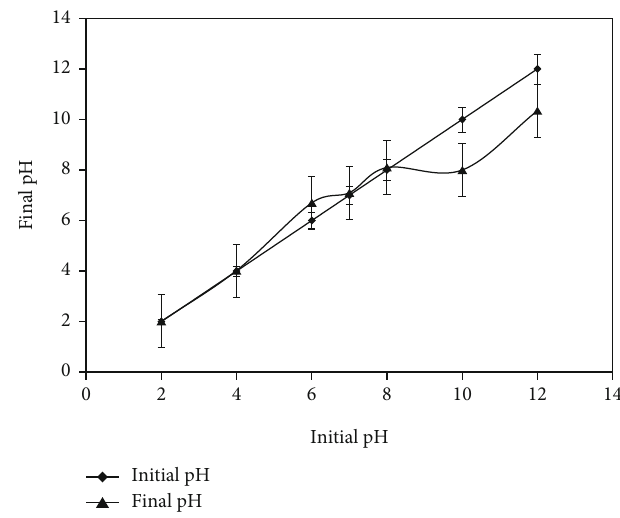
Figure 4: Point of zero charge of